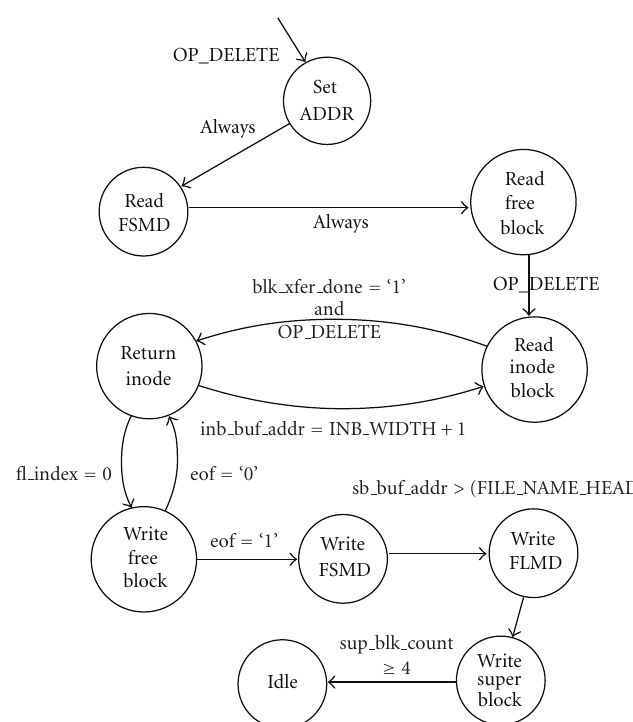
Figure 8: Write file state machine.